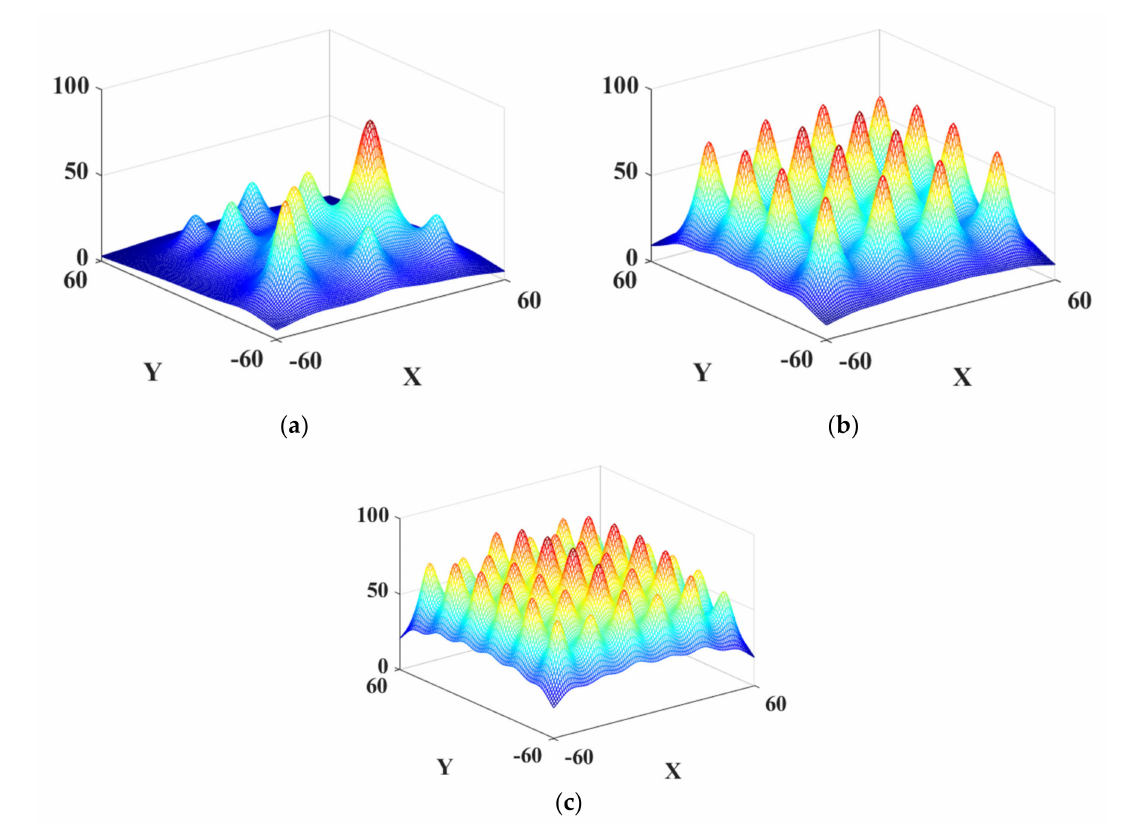
Figure 4. Mathematical multi-modal test function. ( a ) Test function 1 with 11 peaks; ( b ) Test function 2 with 16 peaks; ( c ) Test function 3 with 36 peaks. Table 1. Test result of the IA and